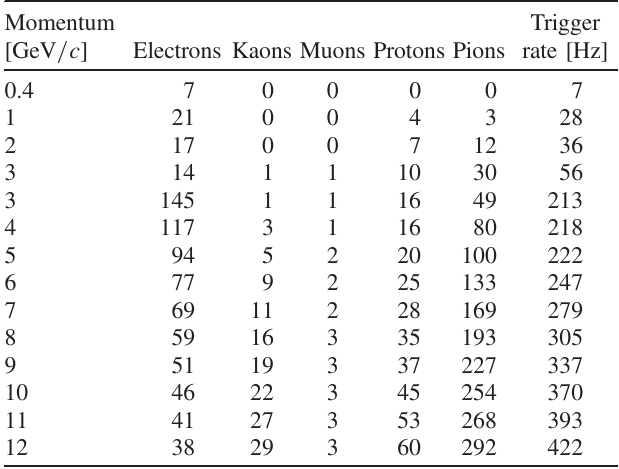
TABLE III. Trigger rate at the NP-02 experiment for a W ( 0 . 4 – 3 GeV =c ) target and a Cu( 4 – 12 GeV =c ) target for the case of H2-VLE. The rates correspond to 10 6 , 80 GeV =c secondary particles generated at the T2